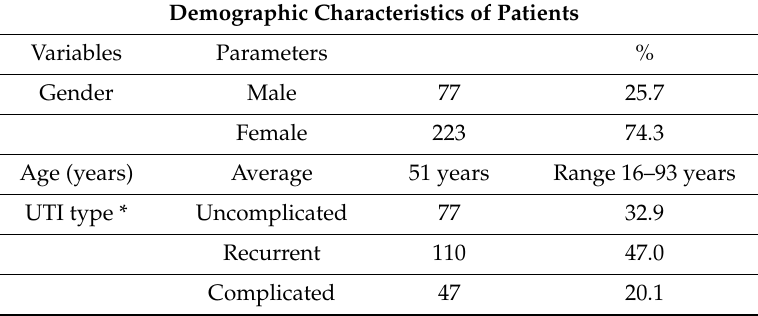
Table 3. Basic demographic data of patients from Cohort 3 (patients evaluated for fosfomycin treatment e ffi cacy). UTI—urinary tract infection.